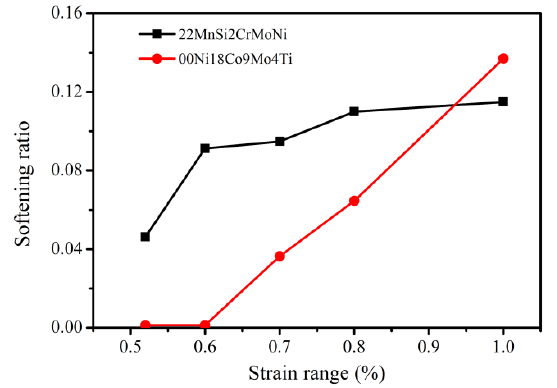
Figure 5. Cyclic softening rate versus strain range of 22MnSi2CrMoNi and 00Ni18Co9Mo4Ti